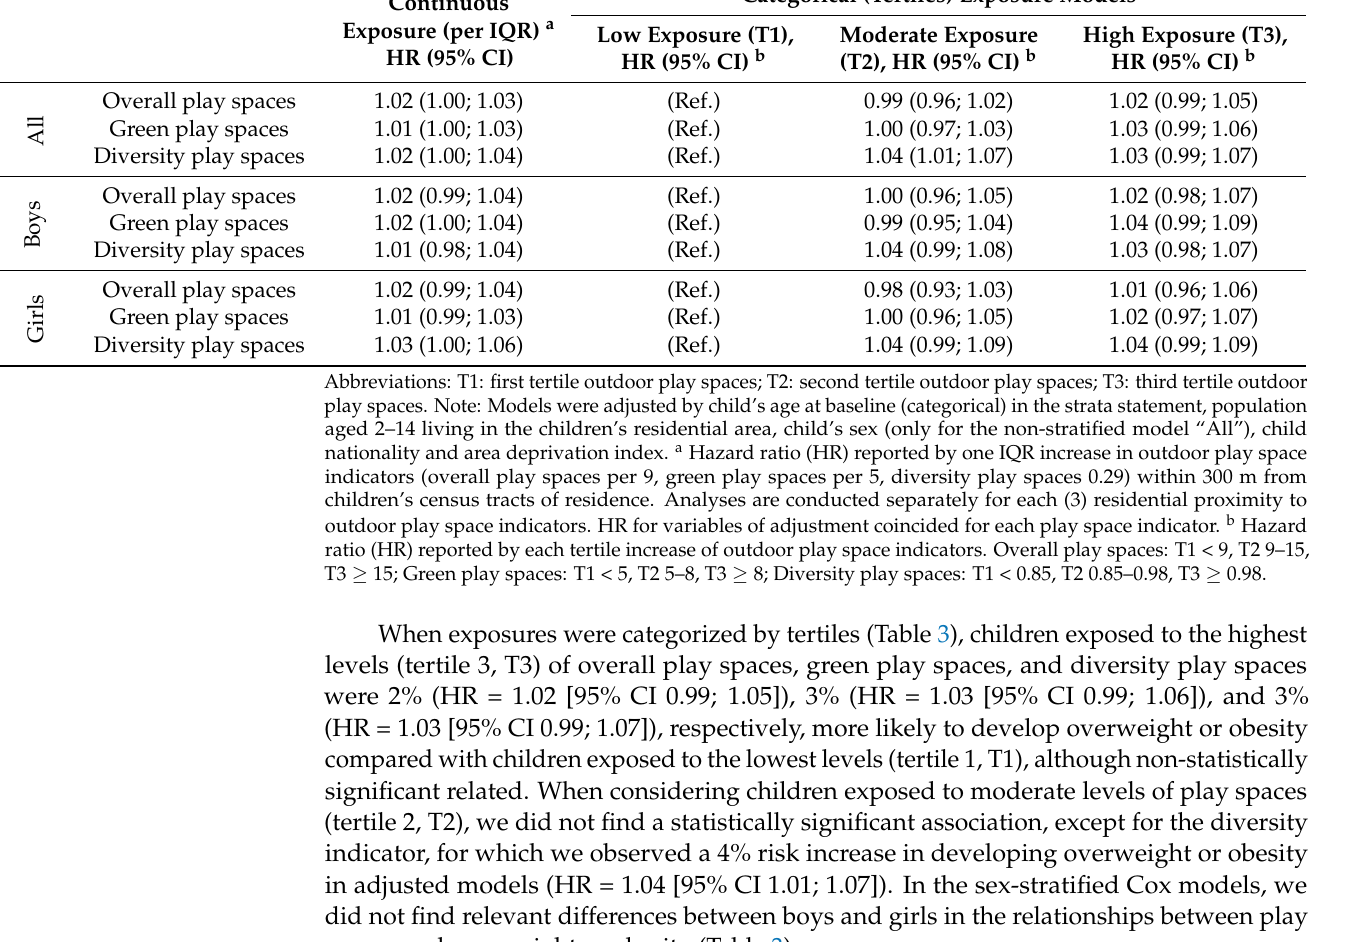
Table 3. Adjusted associations between residential proximity to play spaces (continuous and in tertiles) and the development of childhood overweight or obesity among all children and stratified by sex (N = 75,608). Play Spaces Residential Proximity Categorical (Tertiles) Exposure Models Continuous Exposure (per IQR) a Low Exposure (T1), Moderate Exposure High Exposure (T3), HR (95% CI) HR (95% CI) b (T2), HR (95% CI) b HR (95% CI) b